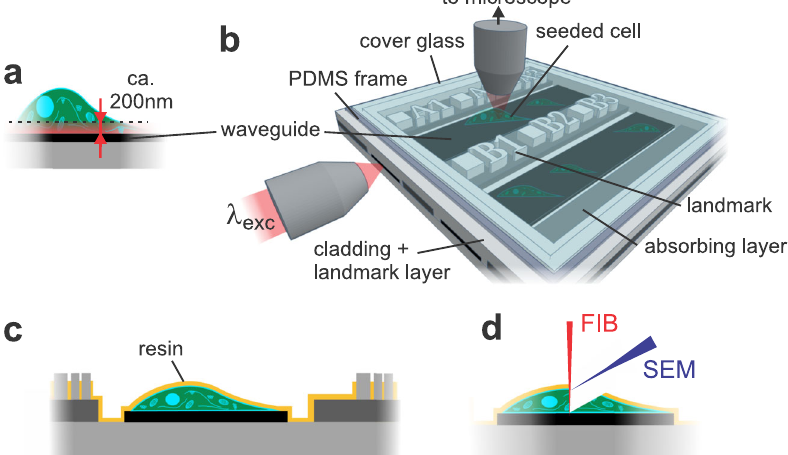
Fig. 1 Working principle of chip-based CLEM. a The evanescent fi eld of the utilized waveguides reaches approximately 200 nm into the sample from the chip surface. b Schematic of chip-based TIRF/dSTORM platform during fl uorescence imaging. The biological sample is placed on top of a waveguide and illuminated by the evanescent fi eld created on top of the waveguide surface. Different layers of the waveguide chip including the landmark system are shown. c After light microscopy, a thin layer of resin (in yellow) stabilizes the specimen while maintaining landmark visibility for quick position retrieval inside the FIB-SEM. d Volume imaging of cell placed on waveguide chip is performed with